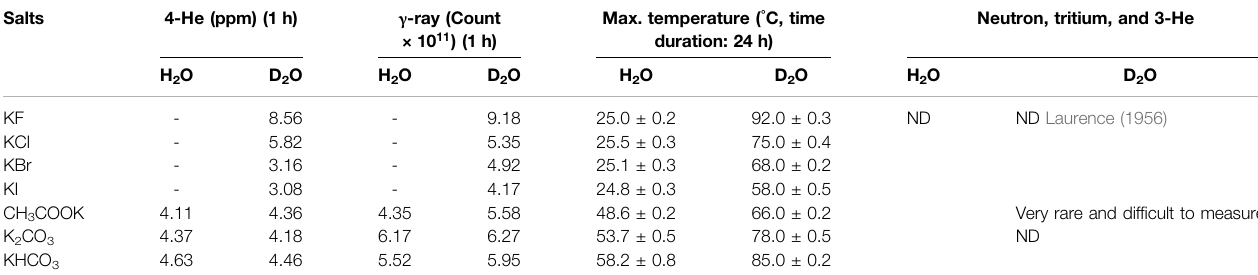
TABLE 2 | Released nuclear fusion products in seven selected salts in both solvents. Salts